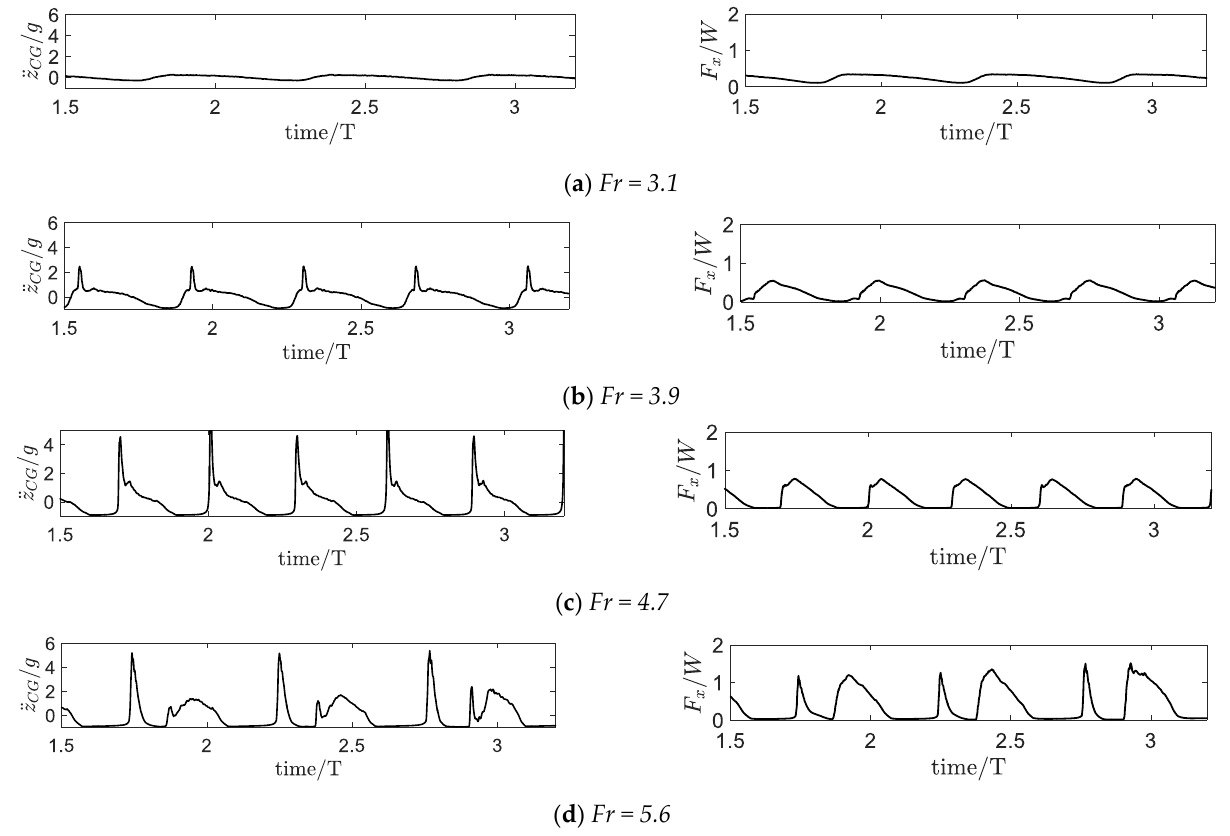
Figure 12. Time histories of the vertical acceleration of Model B at CG and the resistance of the tunneled planing hull in waves. ( a – d ) respectively denote the data corresponding to beam Froude numbers of 3.1, 3.9, 4.7, and 5.6. Note that all the motions are induced by regular waves with wavelengths of 2 L and a wave amplitude 0.0187 L